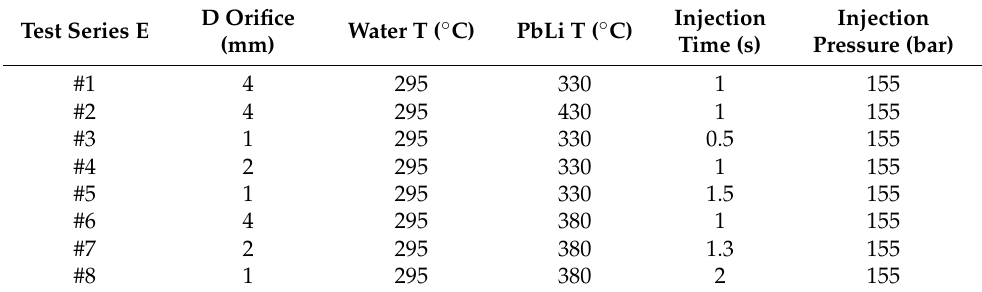
Table 3. Series-E Test